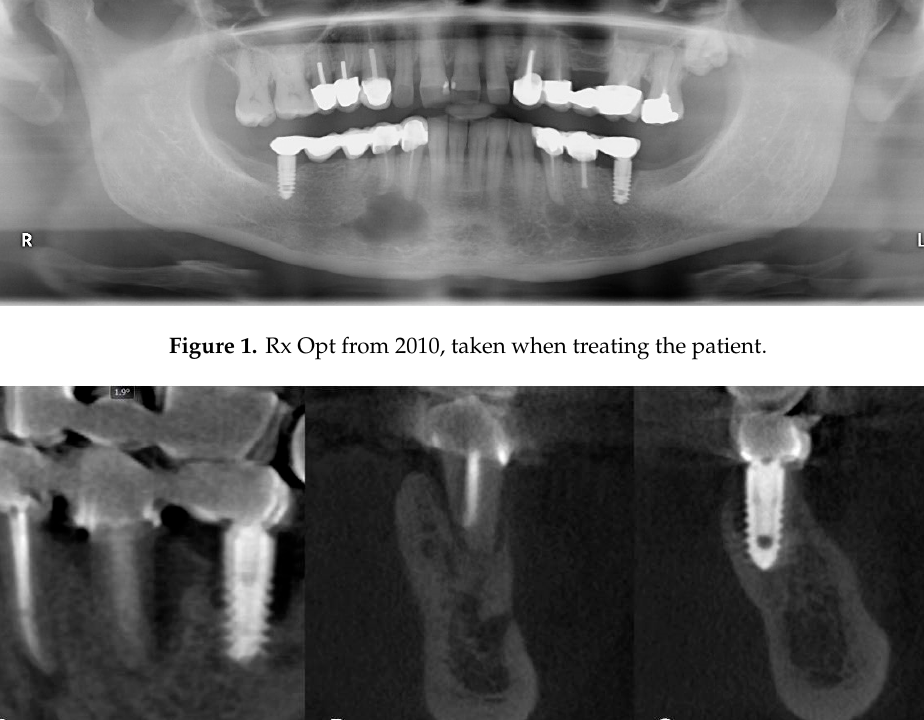
Figure 2. Cone-beam computed tomography (CBCT) analysis (Acteon X-Mind Trium) before surgical treatment showed severe impairment of Region 35 caused by radicular fracture and accentuated peri-implantitis around fixture in Region 36. ( A ) Curved planar reformation, and cross-sections of Regions ( B ) 35 and ( C ) 36 .